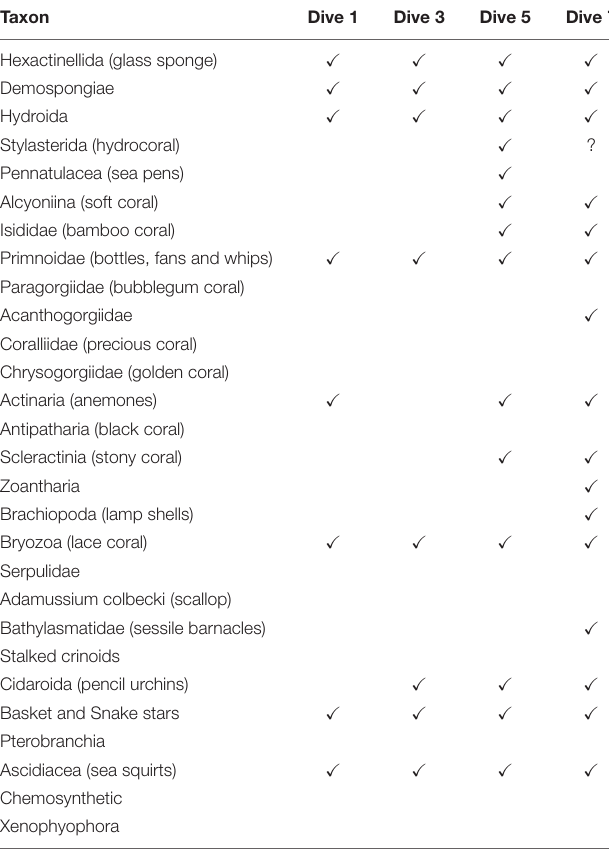
TABLE 2 | Presence of the various VME indicator taxa at four of the dive sites (see Table 1 for details of each site).